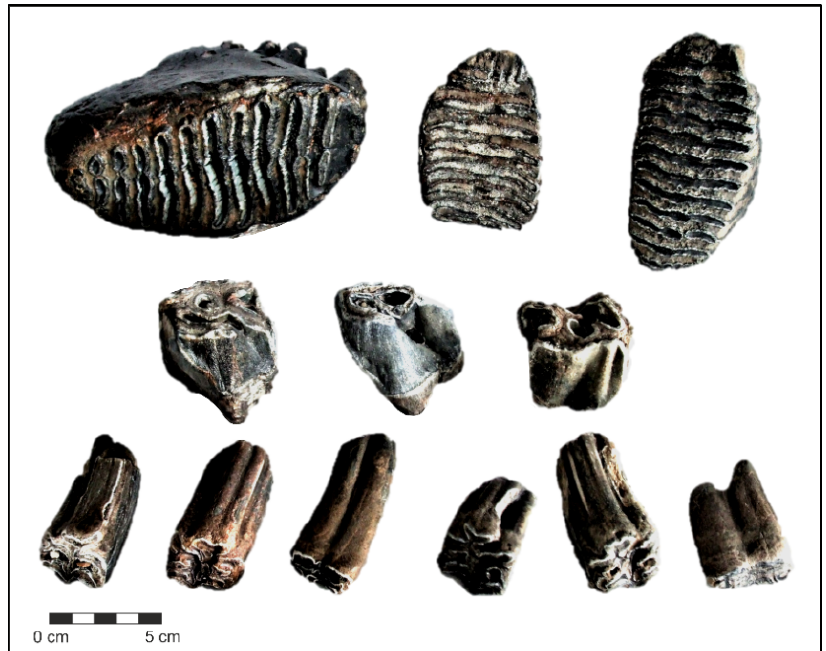
Figure 13. Mammalian teeth from the beach recharge between Clacton and Holland-on-Sea. Top row, mammoth ( Mammuthus sp.); middle, woolly rhinoceros ( Coelodonta antiquitatis ); bottom row, horse ( Equus sp.) Photos: John Ratford.